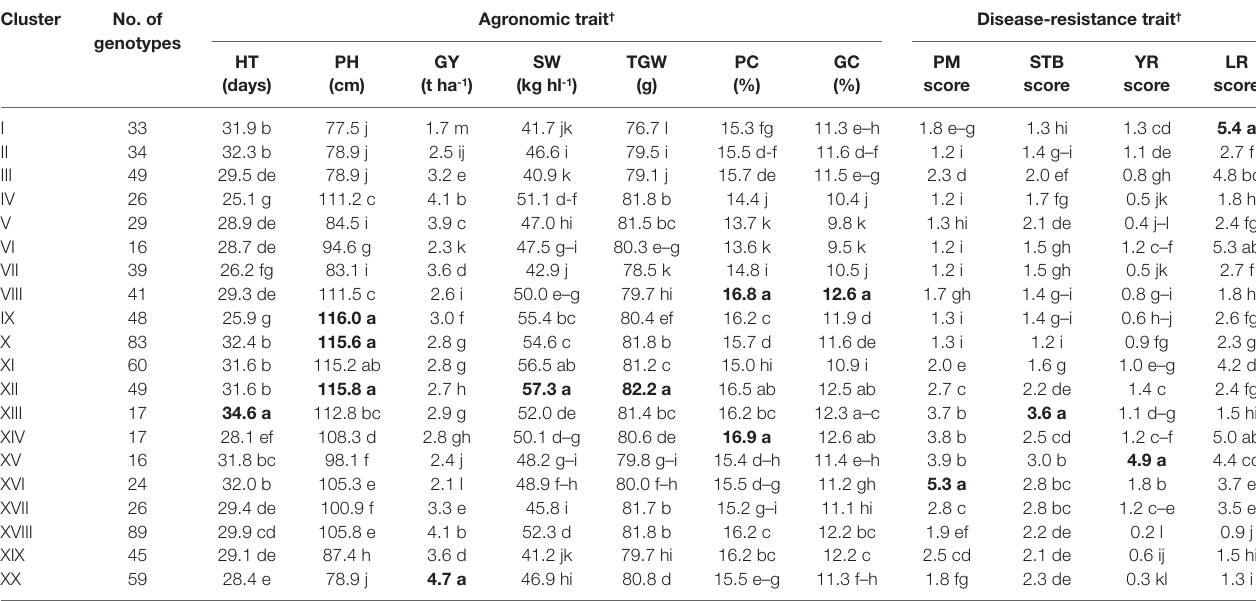
TABLe 6 | Mean values for the 11 agronomic and disease-resistance traits according to the 20 clusters grouped from the cluster analysis of the 800 genotypes derived from the T. durum × T. turanicum crossing. Cluster no. of Agronomic trait † Disease-resistance trait † genotypes HT